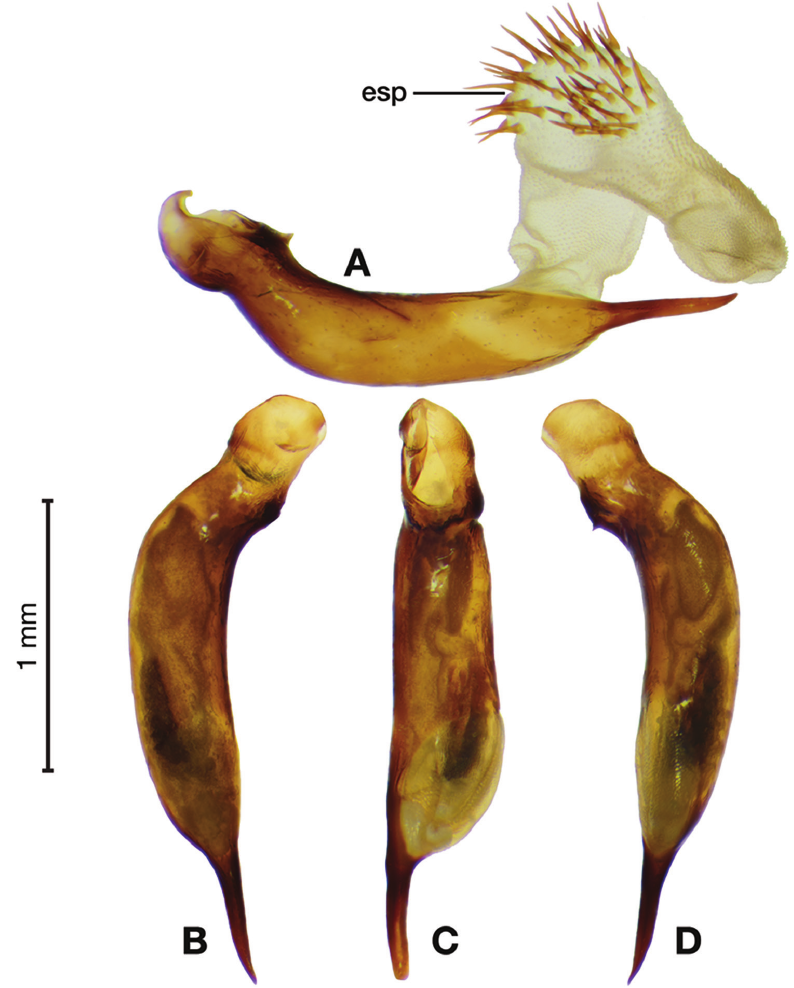
Figure 54. Digital images of male genitalia of C. ( Coptoderina ) proksi Jedlička. A right lateral aspect, endophallus everted B right lateral aspect C ventral aspect D left lateral aspect. Legend: esp endophal- lic spine